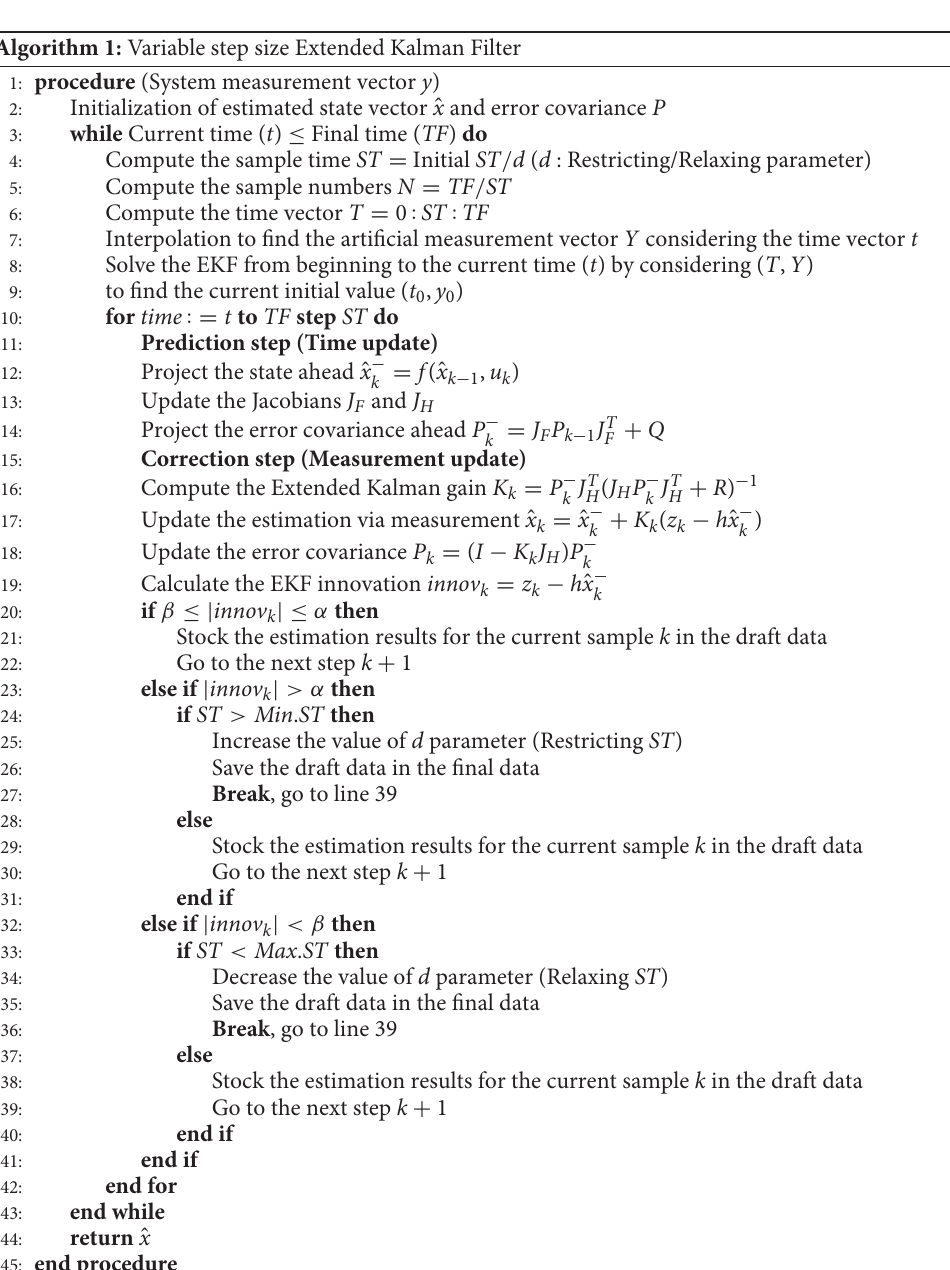
Algorithm 1: Variable step size Extended Kalman